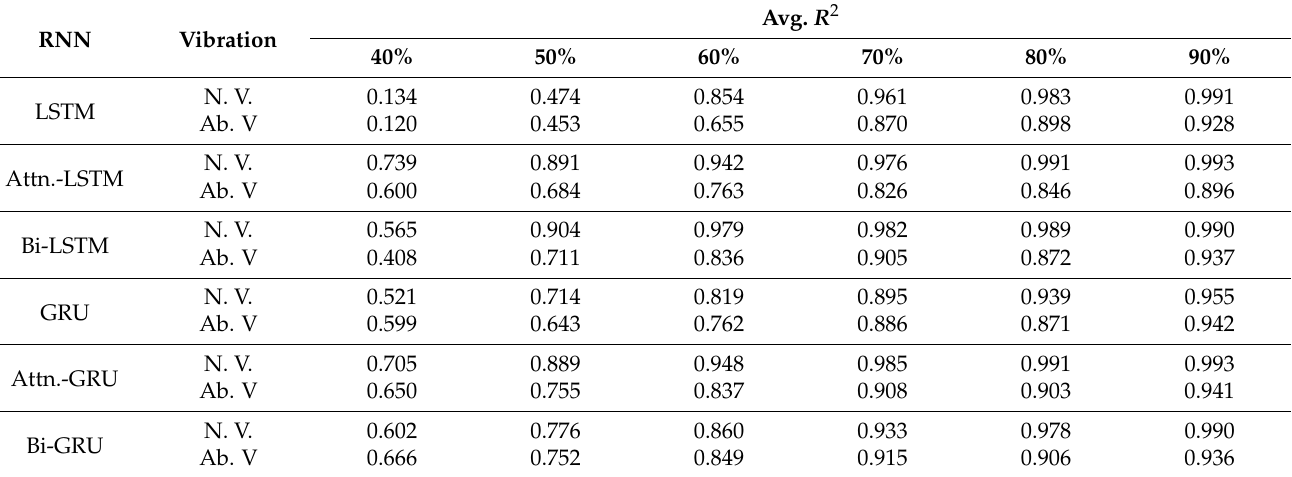
Table 4. The average value of the coefficient of determination for each segment of the training data.